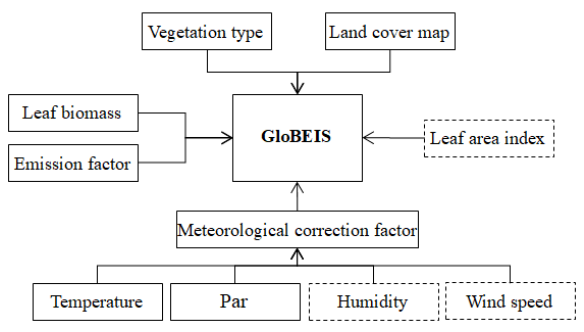
Figure 1. Input parameters for estimation of BVOCs in GloBEIS